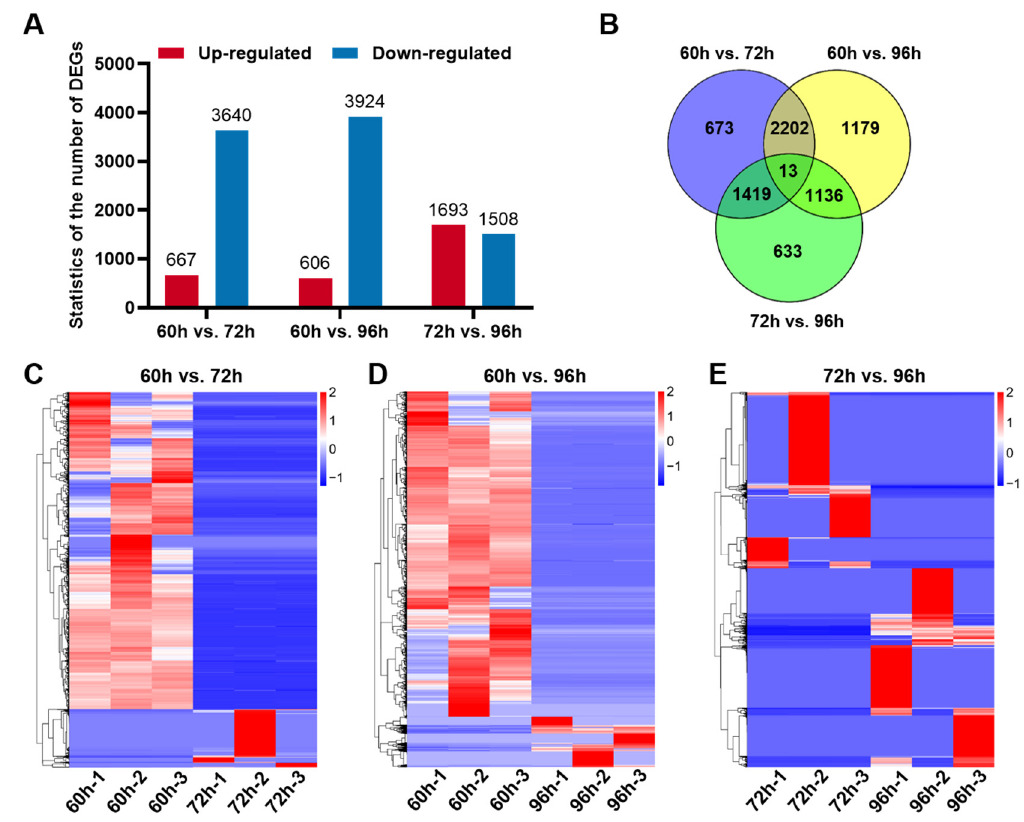
Figure 3. The differentially expressed genes analysis in early liver developmental stages. ( A ) Statistics of differentially expressed genes (DEGs) in hepatocytes between two time points. ( B ) The Venn diagram analysis of DEGs in hepatocytes among three time points. Heatmaps of DEGs between two time points, including 60 and 72 hpf ( C ), 60 and 96 hpf ( D ), as well as 72 and 96 hpf ( E ). As shown in cluster heatmaps, a striking difference in the expression of genes can be found in hepatocytes between two time points and most DEGs at 72 hpf or 96 hpf were down-regulated in comparison with the expression of corresponding genes at 60 hpf (Figure 3C–E), suggesting that the differentiation of hepatocyte functions occurred from 60 to 96